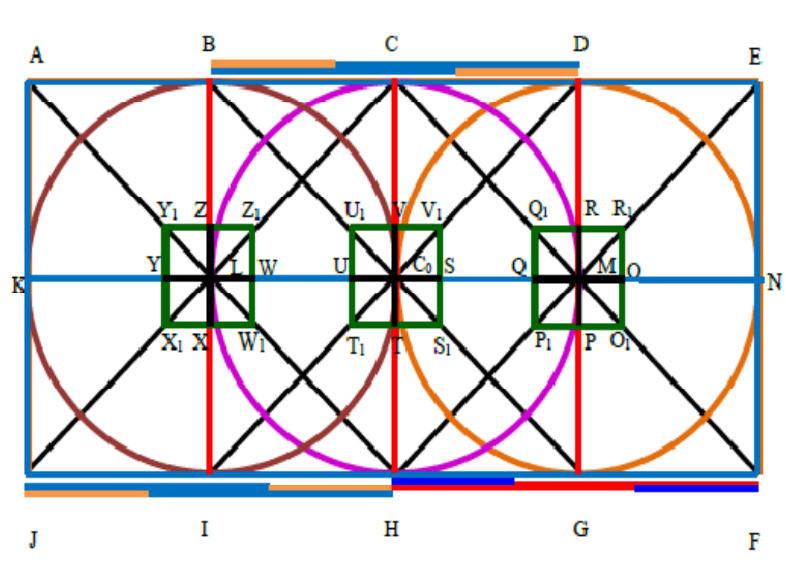
Figure 6. Golden section of the